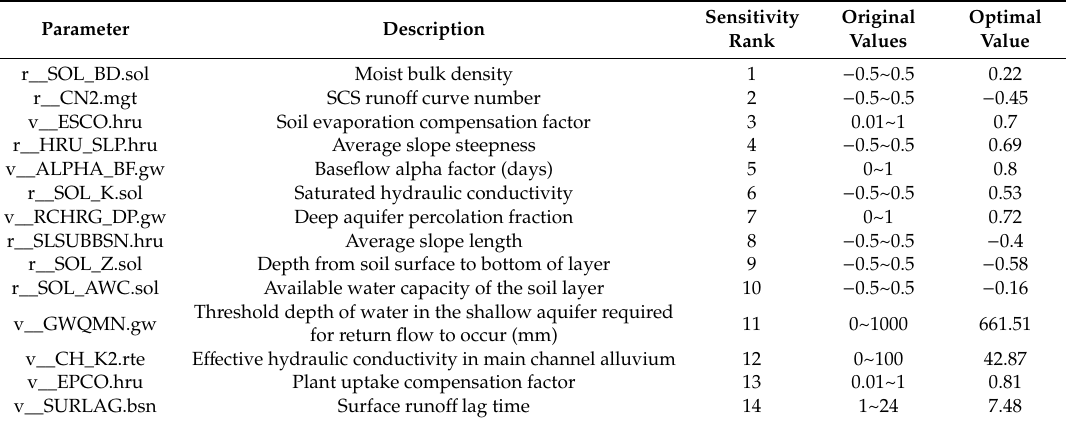
Table 6. Optimal parameters for the Soil Water and Assessment Tool (SWAT) model.